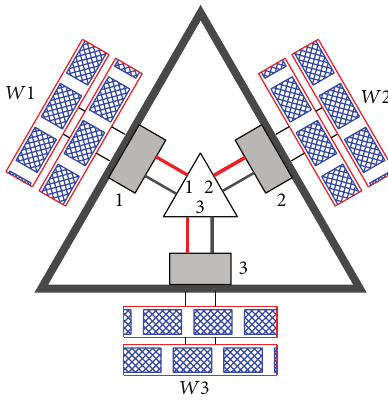
Figure 7: Reverse movement schematic of